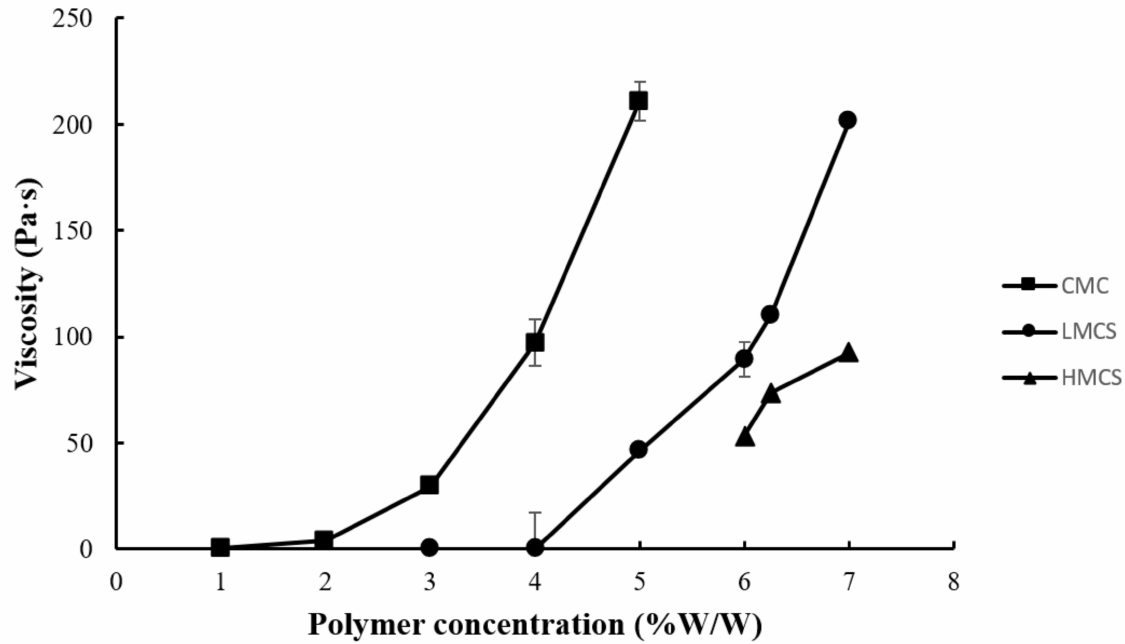
Figure 2. Viscosity at shear rate of 1 s − 1 of the gels prepared from different concentrations of carboxymethyl cellulose (CMC), low molecular weight chitosan (LMCS), and high molecular weight chitosan